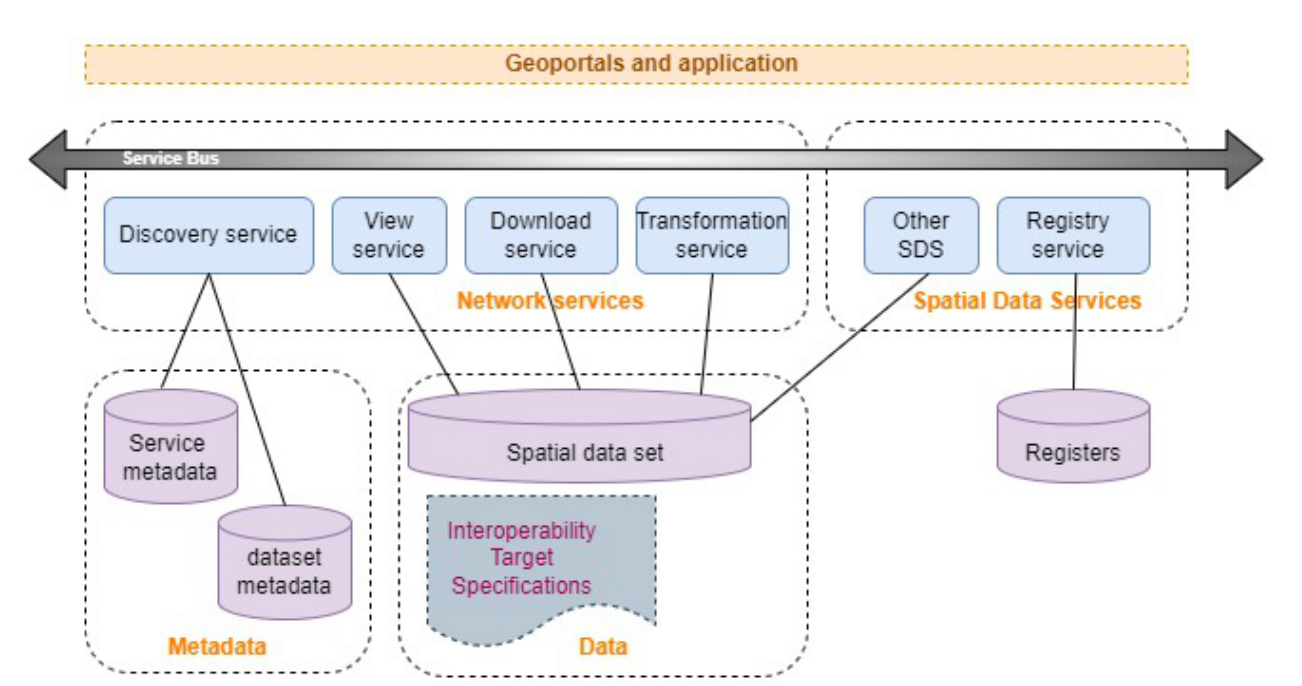
Figure 4. Distributed service oriented architecture of INSPIRE. Source: European Commission, Joint Research Centre. (figure source